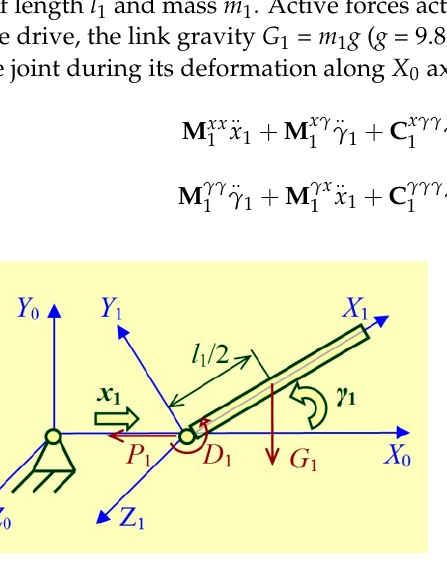
Figure 3. Calculation scheme.